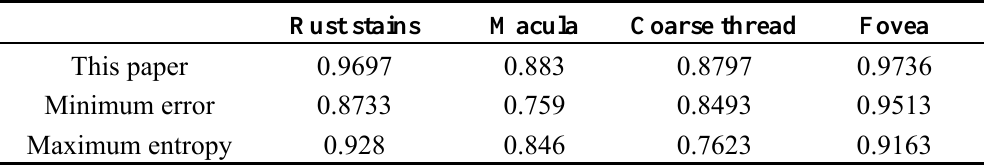
Table 5. S estimation factor